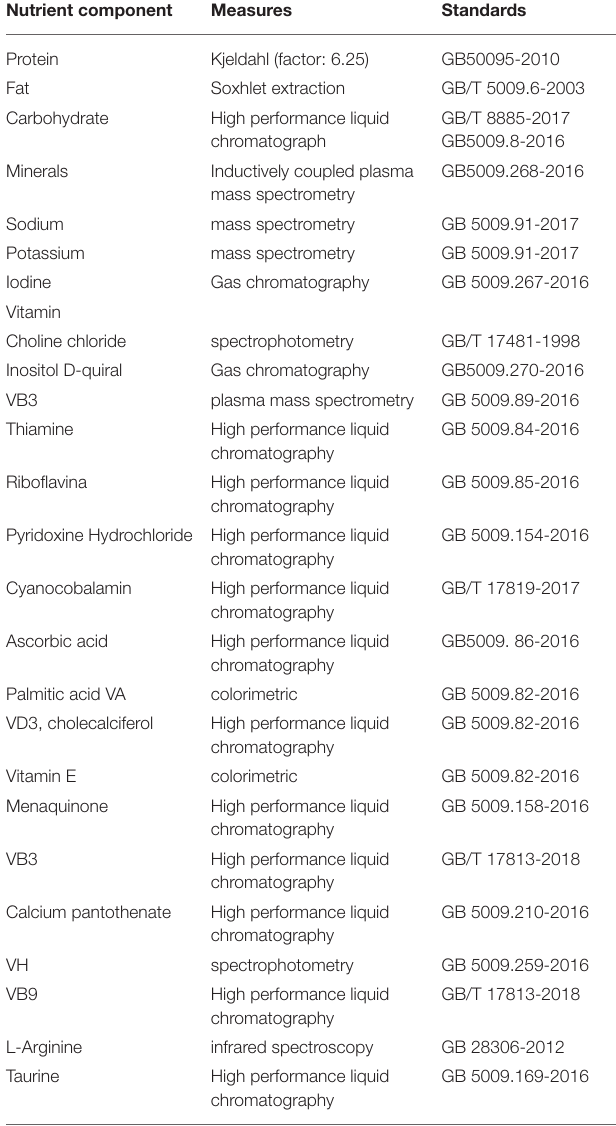
TABLE 2 | The methods and standards for the analysis of enteral formula’s nutrient composition. Nutrient